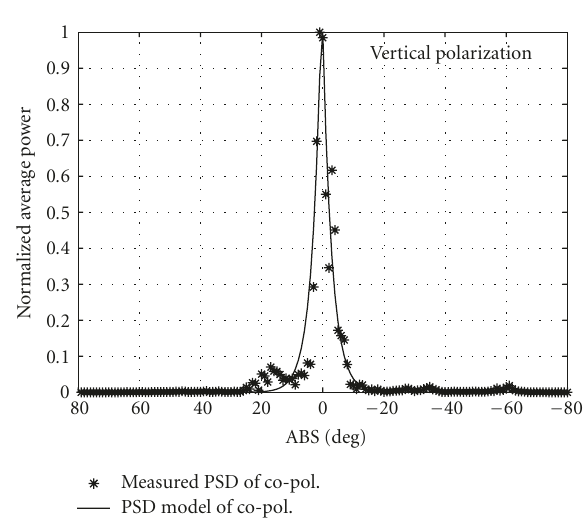
Figure 11: ABSPSDs for a { VV } of street I (NS). 0 ◦ is the ABS towards the